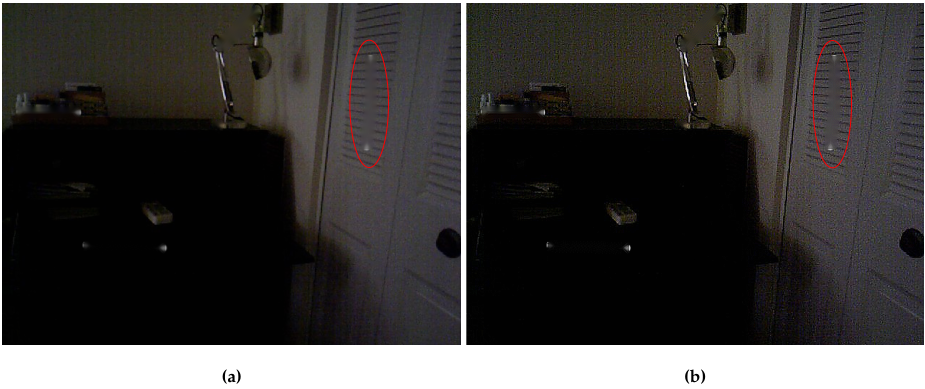
Figure 6. Image sharpening results. ( a ) Input. ( b ) Result.